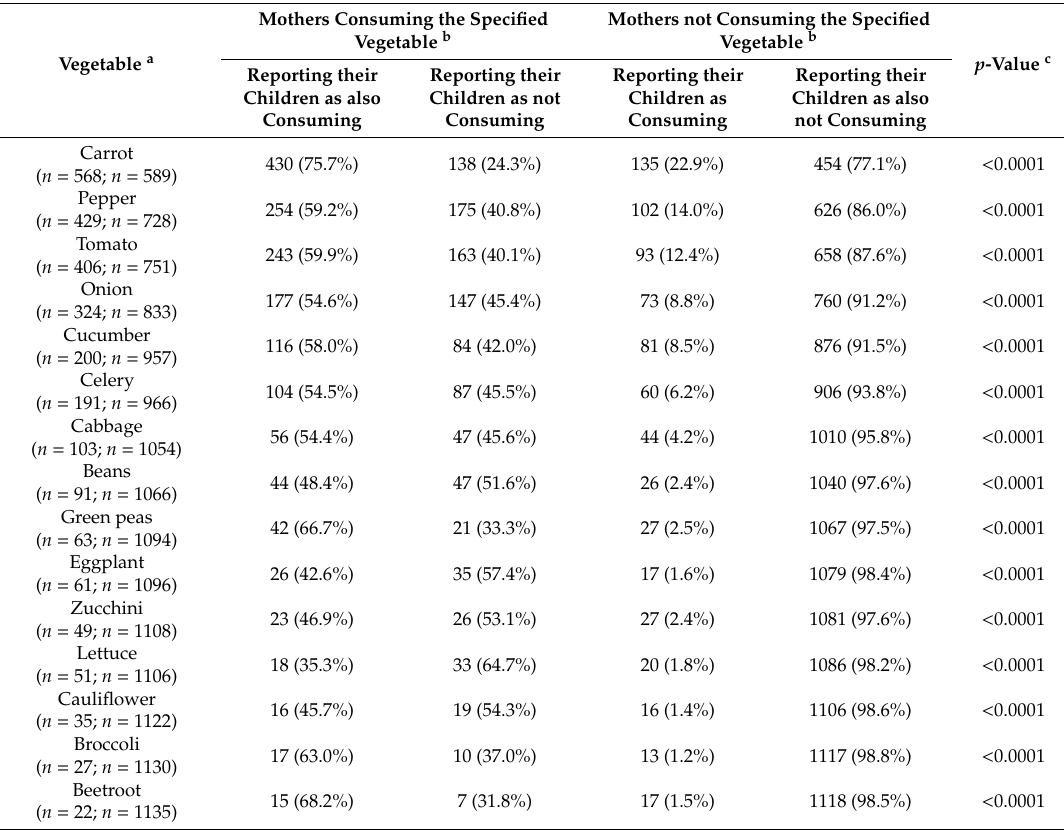
Table 4. Analysis of the association between the vegetable consumption behaviors self-reported by the mothers and reported by them for their children, in a nationally representative sample of Romanian mother–child pairs ( n =